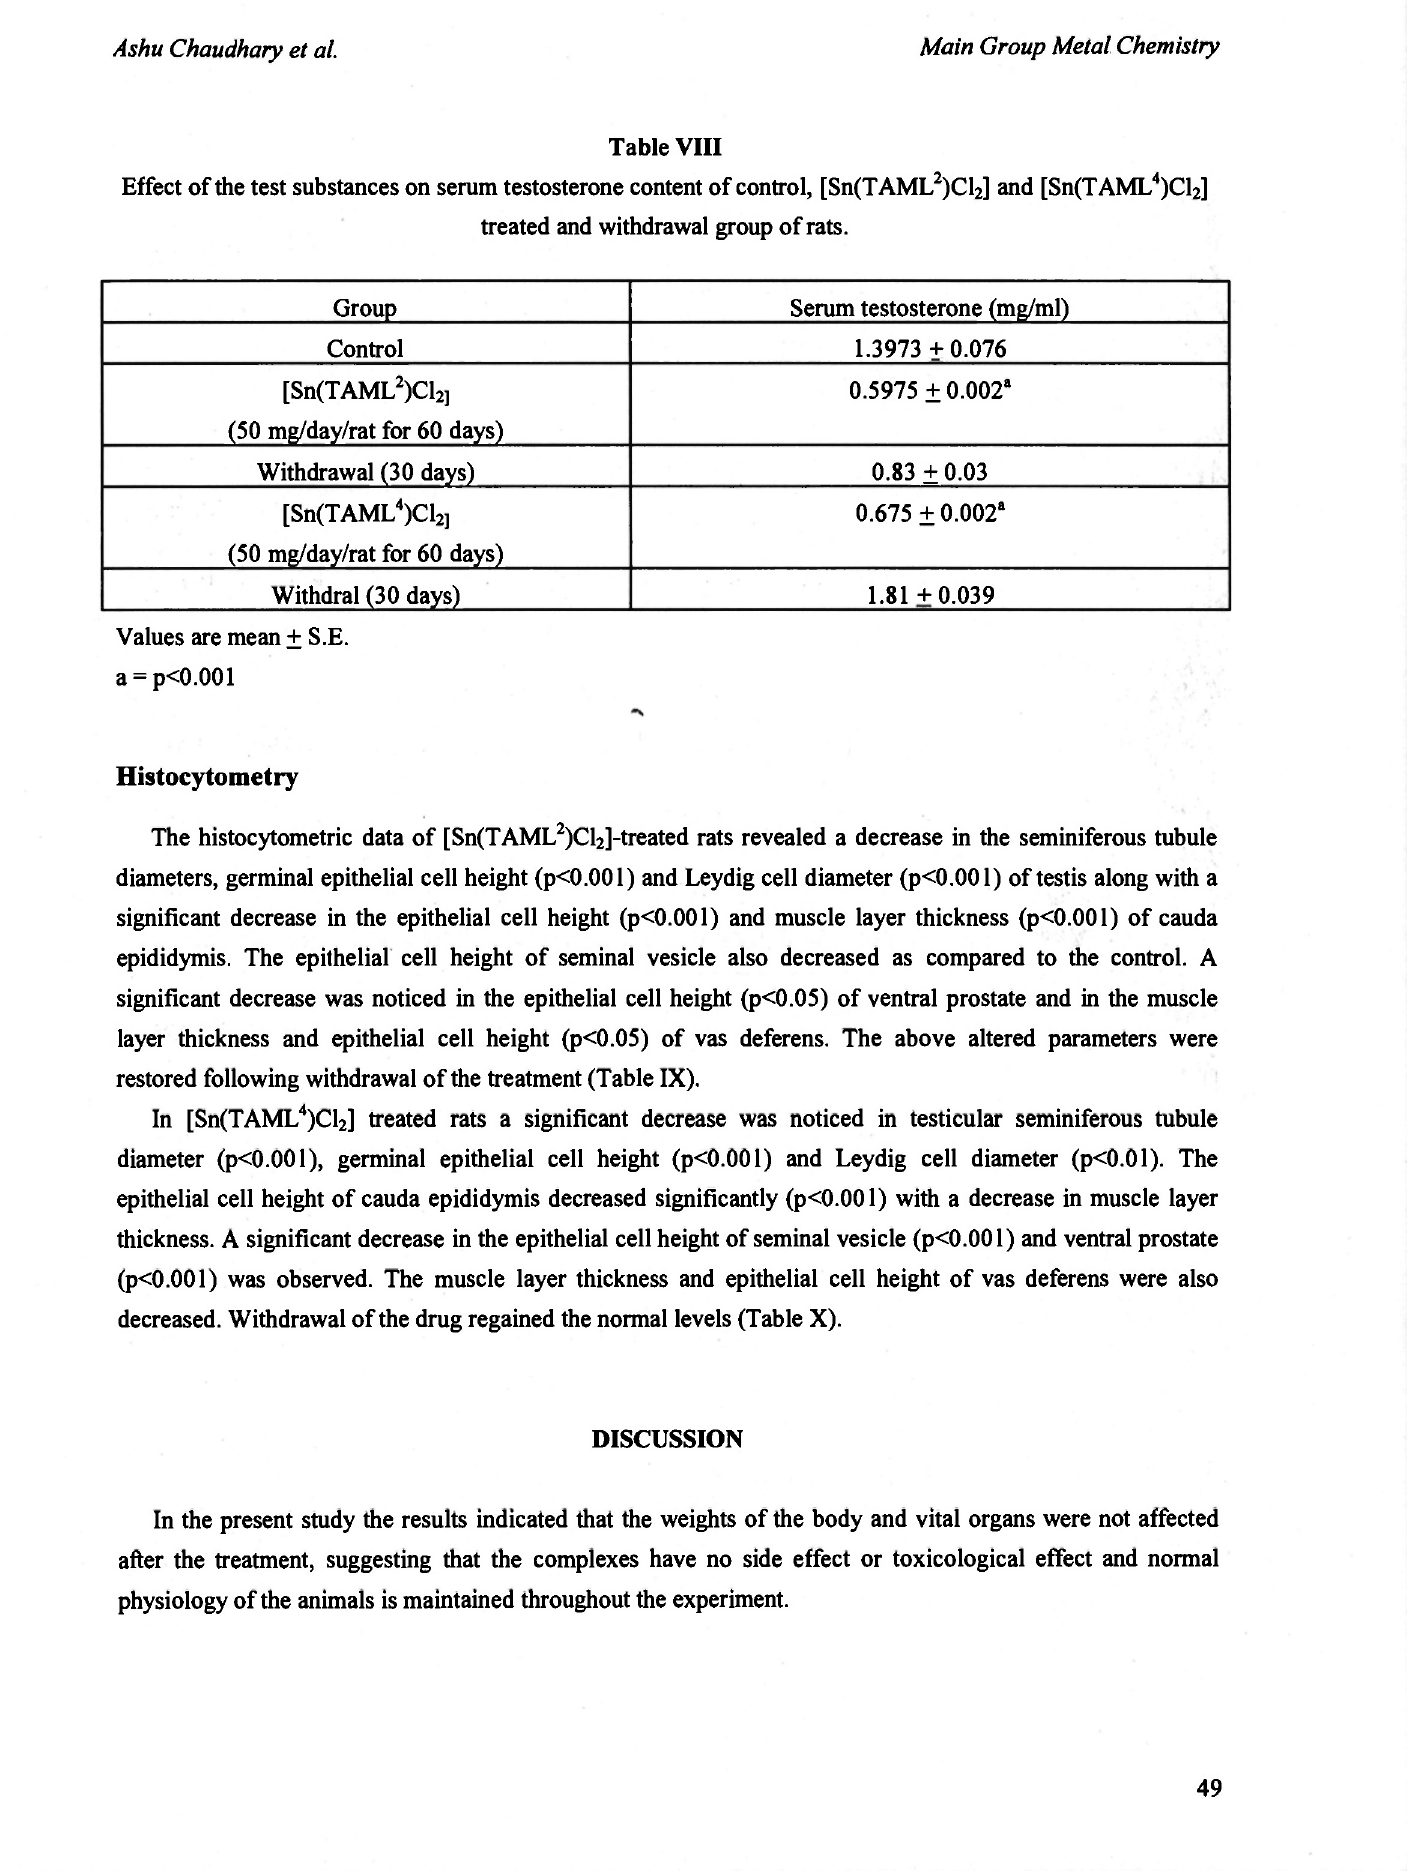
treated and withdrawal group of